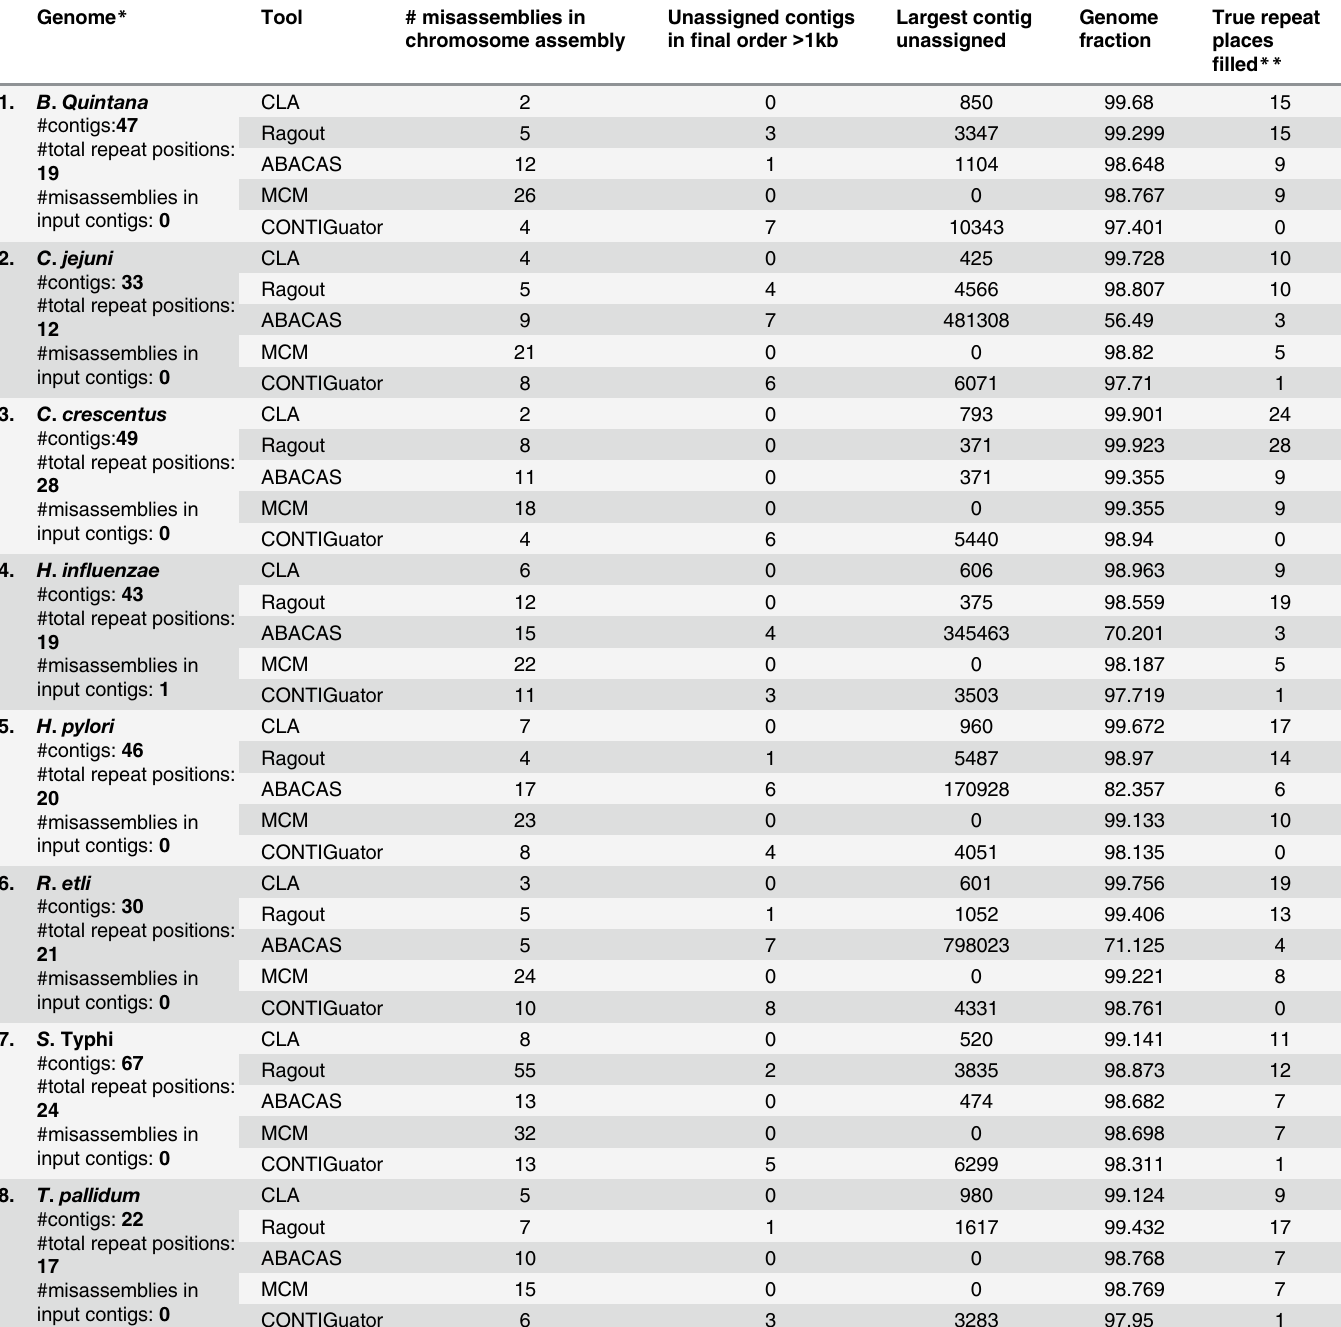
Table 1. Comparative statistics of CLA and reference based alignment tools generated using simulated dataset. Genome * Tool # misassemblies in